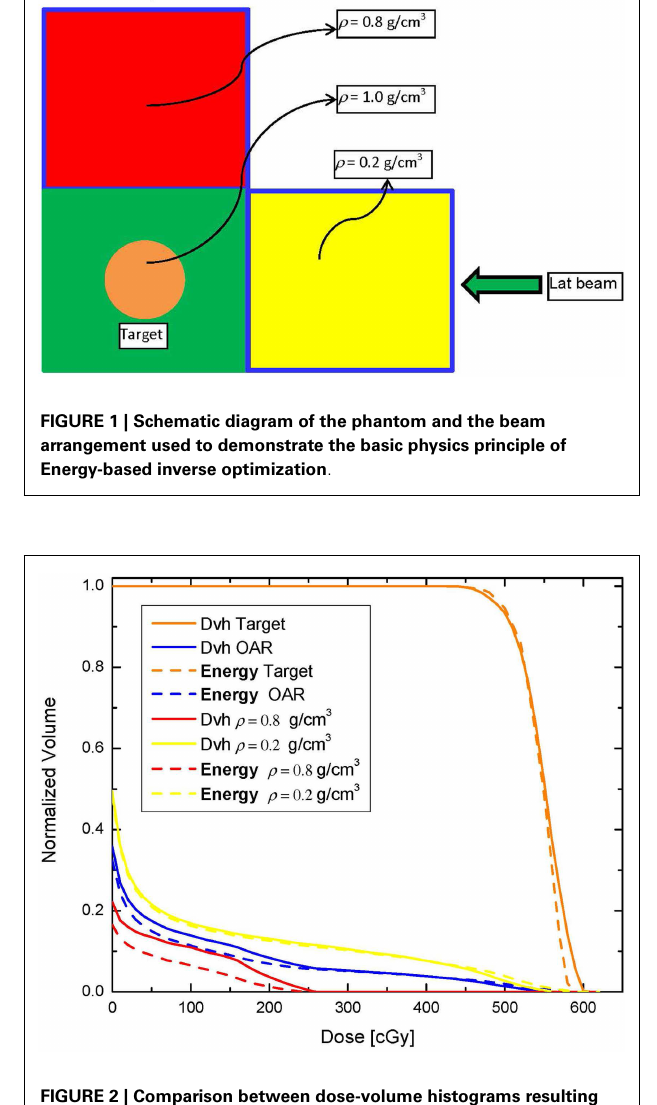
FIGURE 2 | Comparison between dose-volume histograms resulting from Dvh-based and Energy-based optimization